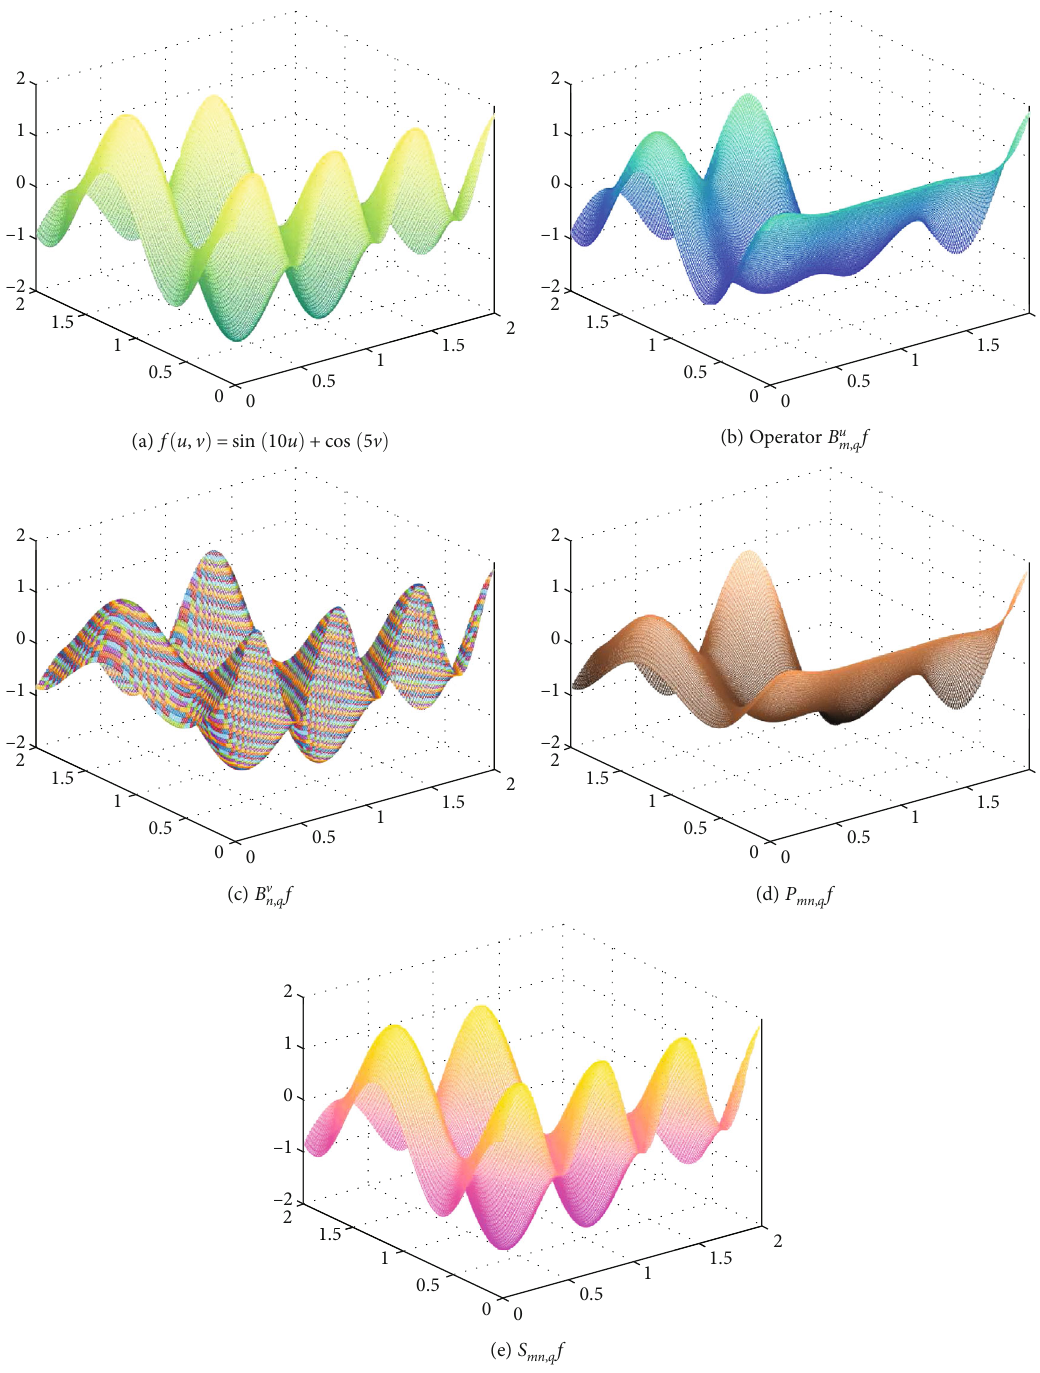
f , B v f , P f , and S f approximating function on triangular domain for h = 2 , m = 10 , n = 10 , and q = 0 : 99 mn , q mn , q m , q n , q